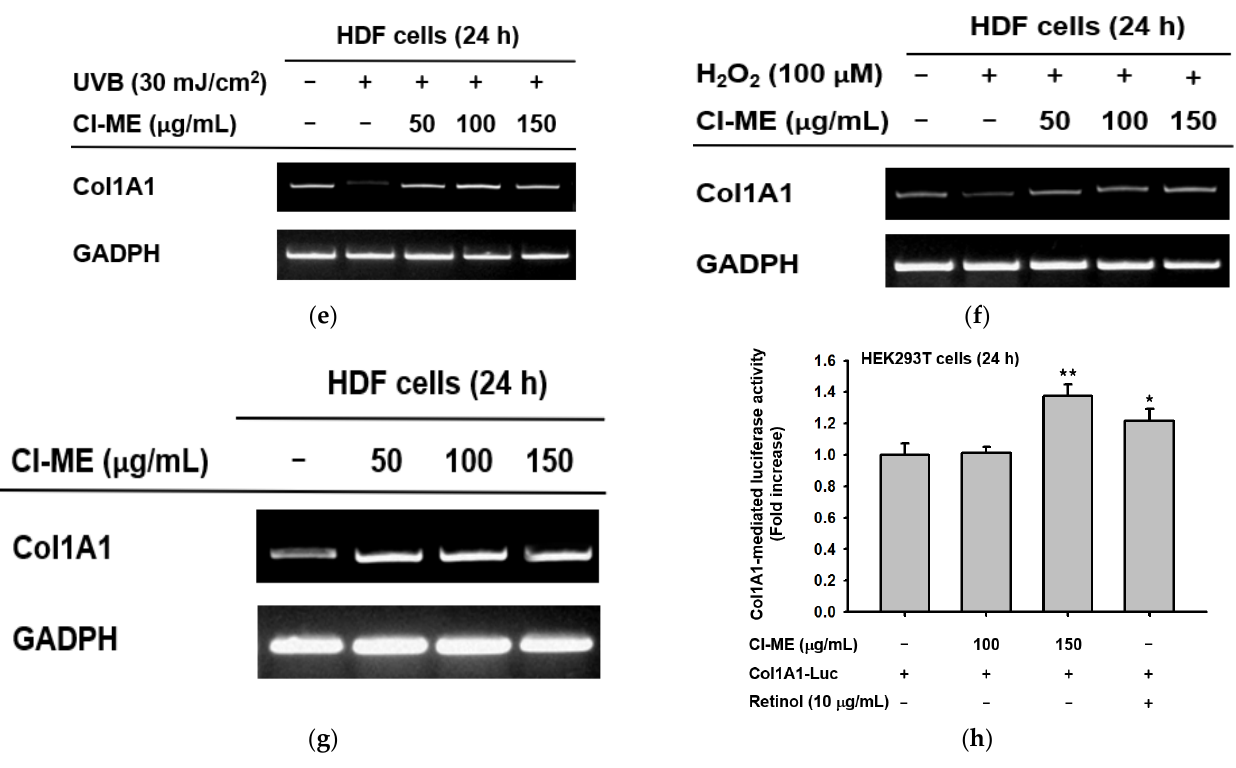
Figure 3. Prevention of moisture loss and collagen degradation and the effect of collagen formation of Cl-ME. ( a , b ) Expression of COX-2 in UVB (30 mJ/cm 2 )- or H 2 O 2 -(100 µM) treated HaCaT cells after 24 h treatment with Cl-ME. ( c , d ) Expression of MMP-1, MMP-9, HYAL-1, and HYAL-4 in HaCaT cells after a 24 h treatment with H 2 O 2 and Cl-ME. ( e , f ) Recovery of Col1a1 expression in UVB-treated (30 mJ/cm 2 ) or H 2 O 2 -treated HDF cells after 24 h of treatment with Cl-ME. ( f ) Recovery of Col1a1 expression in HDF cells after a 24 h treatment with H 2 O 2 and Cl-ME. ( g ) Expression of the Col1a1 gene in HDF cells after a 24 h treatment with Cl-ME. ( h ) Col1a1-mediated luciferase activity in HEK293T cells, measured after 24 h of treatment with Cl-ME; retinol was used as the positive control. * p < 0.05 and ** p < 0.01 compared to the control group.